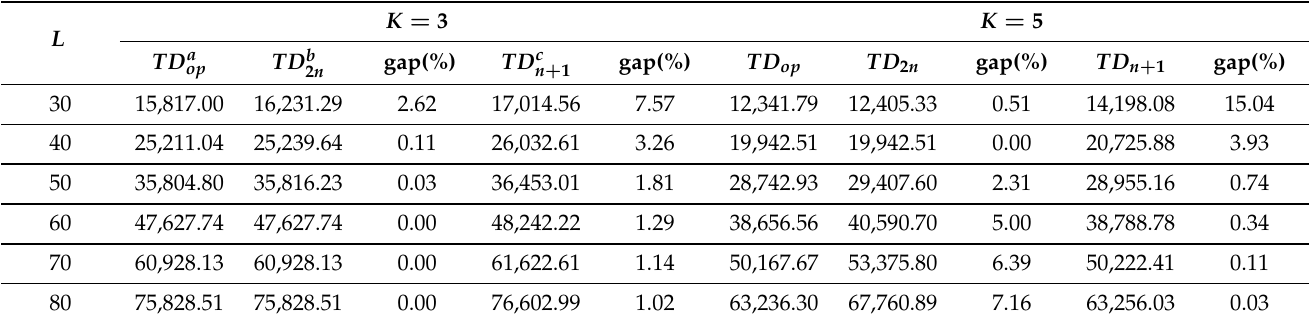
Table 7. Evaluation of two rules for a flying-V layout with varying lengths and odd workstation numbers.